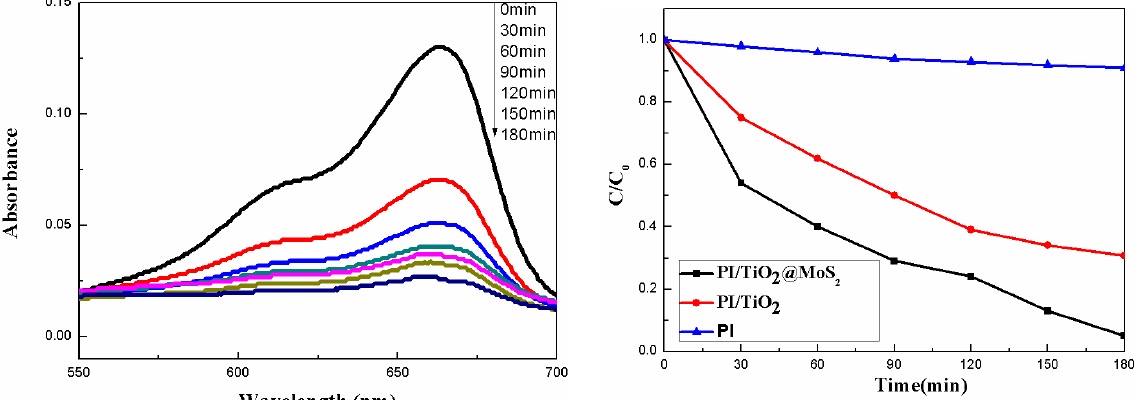
Figure 8. UV – Vis absorption spectra of methylene blue (MB) as a function of UV-light irradiation time ( λ = 36 5 nm) in the presence of the PI/TiO 2 @MoS 2 composites fiber (left); MB concentration changes with the as-prepared samples (right).